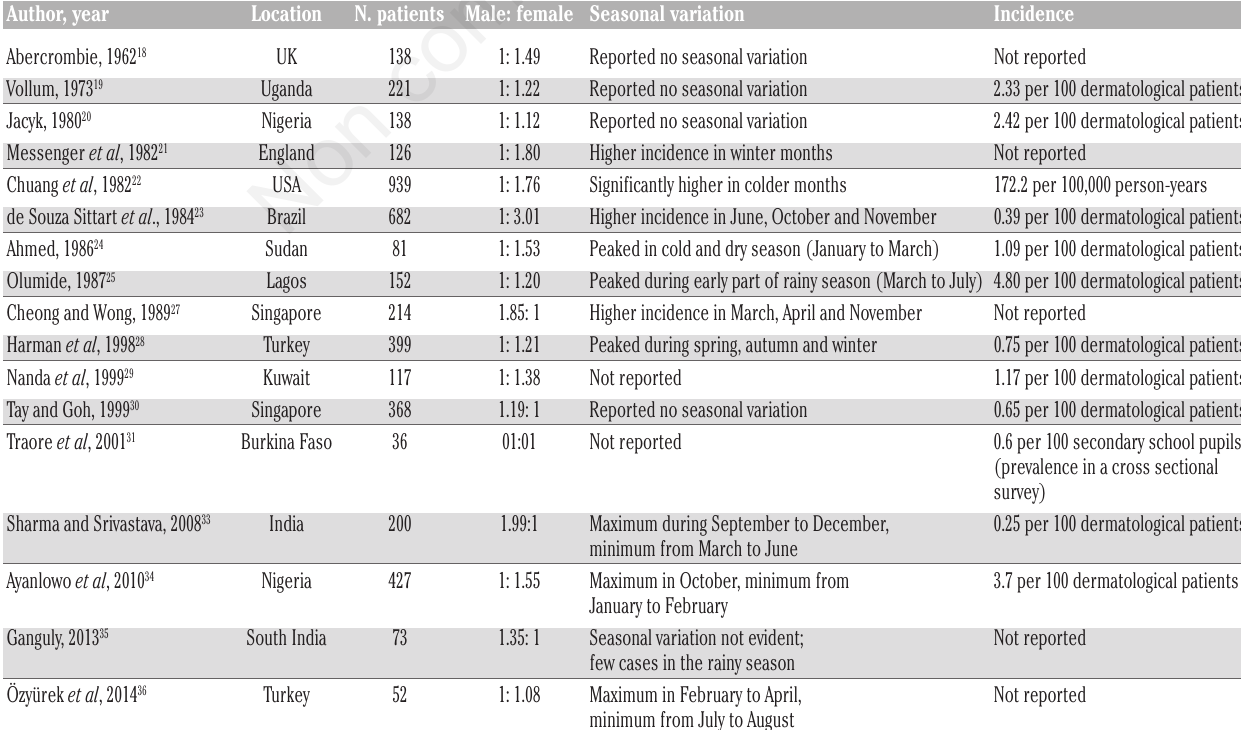
Table 1. Summary of epidemiological studies on pityriasis rosea. Author, year